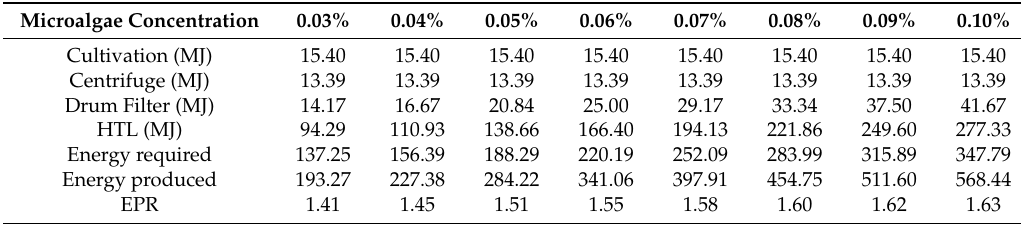
Table 8. Energy profit ratio from scenarios with a culture depth of 0.2 m. Microalgae